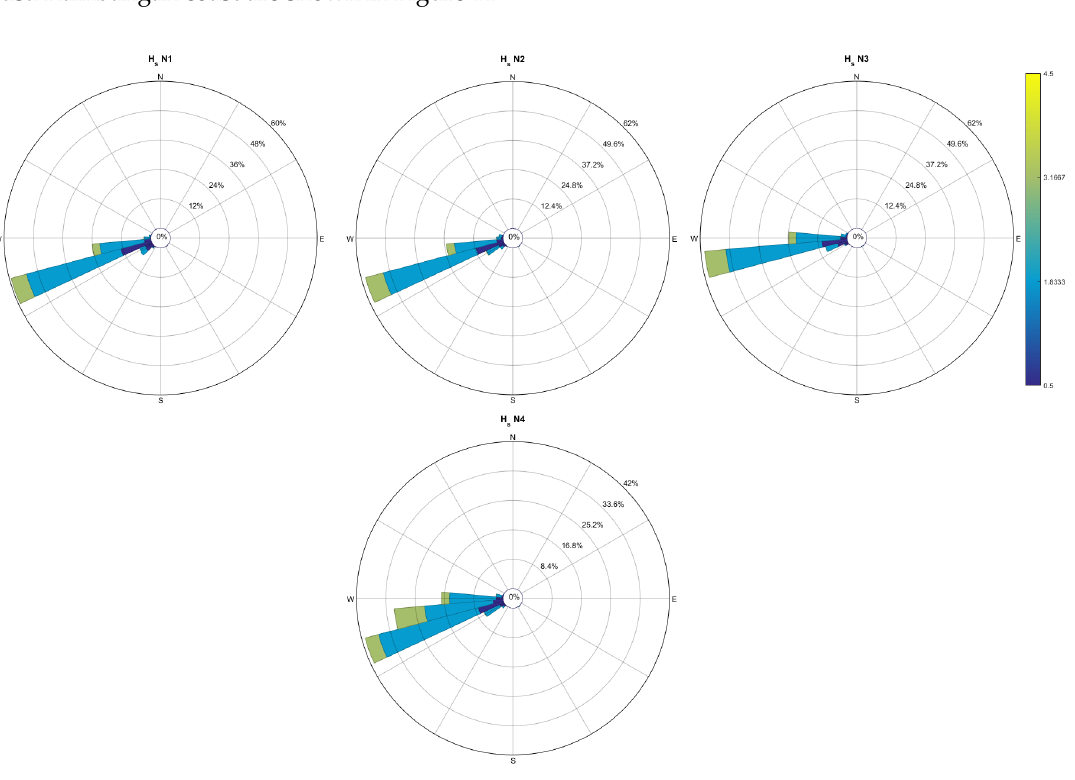
Figure 11. Polar diagram of yearly significant wave height for the prospective locations in Nusa Kambangan coast where N1 to N4 represent pin locations number 1 to number